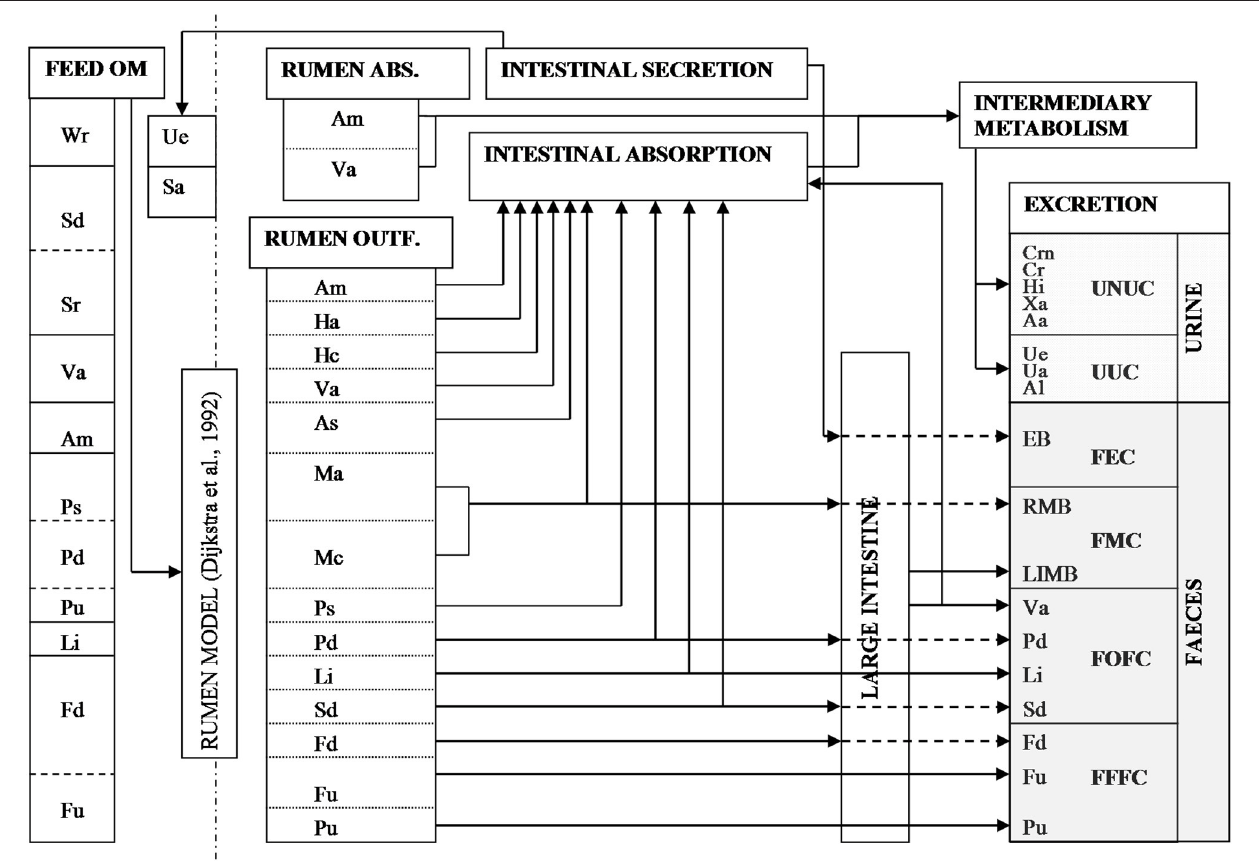
FIGURE 1 | Schematic representation of the model. Abbreviations are explained in Table 1 . Rumen outflow is predicted by the model of Dijkstra et al. (1992). The arrows represent static equations that describe the fluxes (g day − 1 ) of different components through the digestive tract.